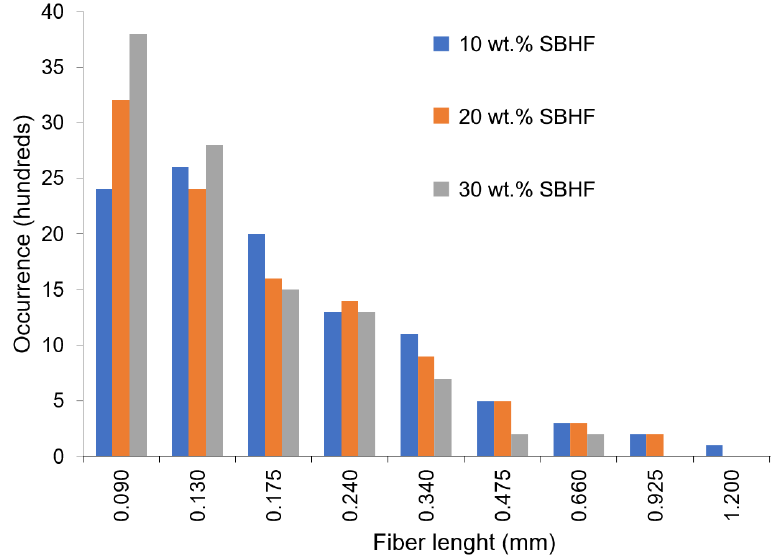
Figure 3. Length distribution of the fibers recovered from PLA/SBHF composites. The horizontal axis indicates the median of each length interval considered. Table 3. Assessment of tensile strength at the level of constituent materials: inputs and results from the Bowyer and Bader solution (Equation (3)) and the modified rule of mixtures (Equation (1)). SBHF Proportion 10 wt.% 20